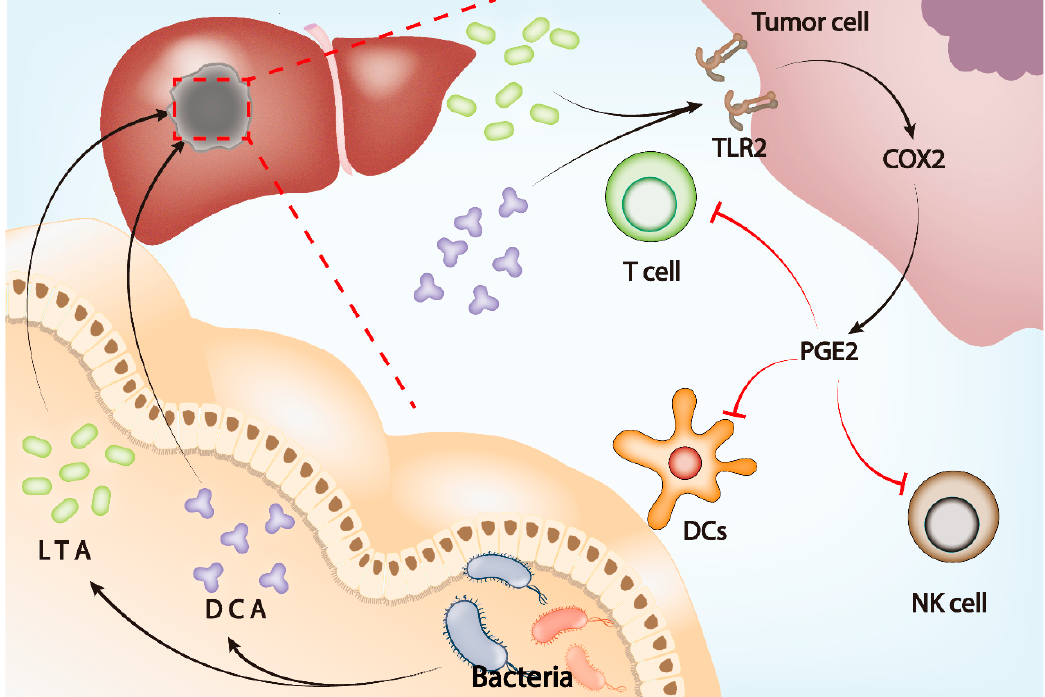
Figure 3. Gut microbiota influences tumor microenvironment through the gut–liver axis. LTA and DCA, metabolites of gut microbiota, upregulate the expression of COX2 by activating TLR2 on the tumor cell membrane, leading to the upregulation of PGE2 in the tumor microenvironment. Elevated PGE2 inhibits the function of DCs, T cells, and NK cells and ultimately induces an immunosuppressive microenvironment to assist tumor immune escape.